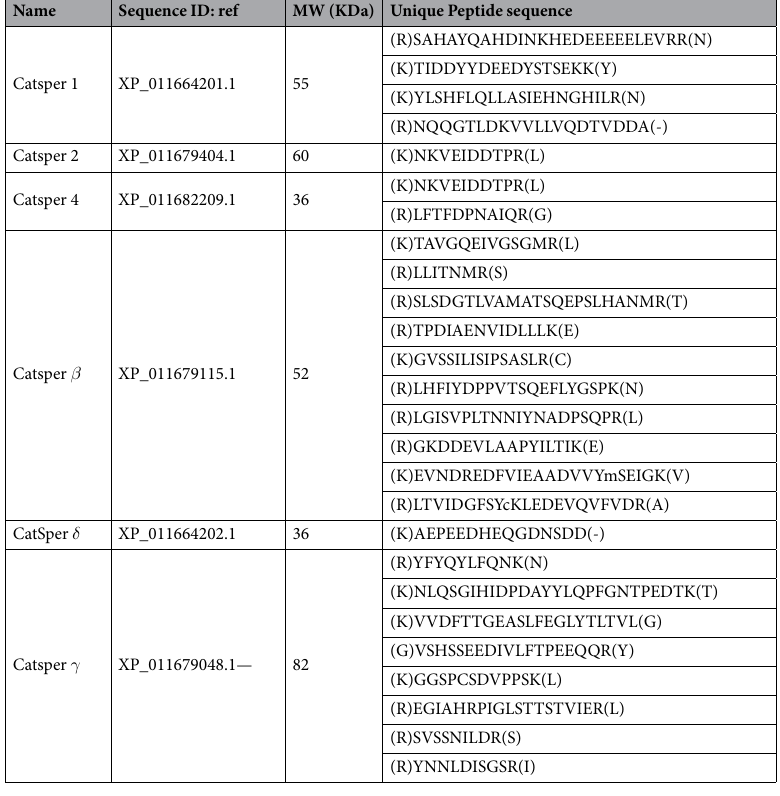
Table 1. Different cation channel sperm-associated proteins (CatSper) family members identified by proteomic analysis, including sequence ID: ref numbers, molecular weights (MW; KDa) and peptide amino acid